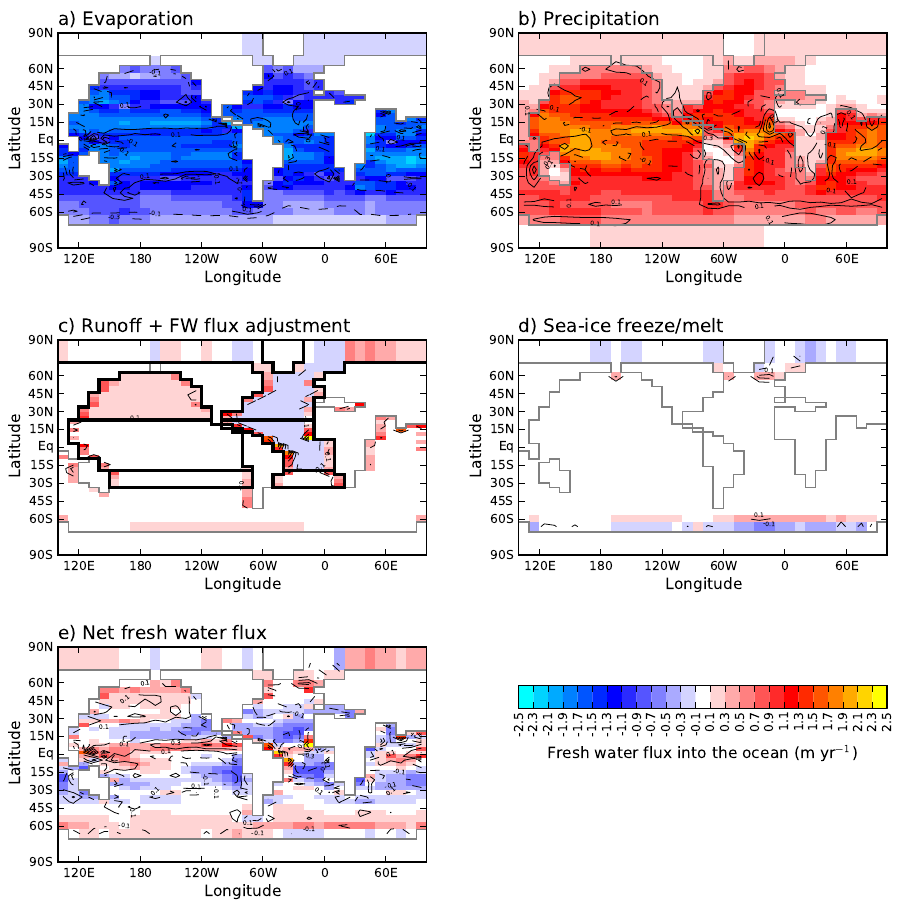
Fig. 18. Annual-mean components of freshwater flux (m year − 1 ) into the ocean for 3636s16l (maps) and “3636s16l” minus “biogem” differences (contours). Bold-outlined areas in (c) represent the three pairs of regions for Atlantic-to-Pacific freshwater flux adjustment as shown by Marsh et al.